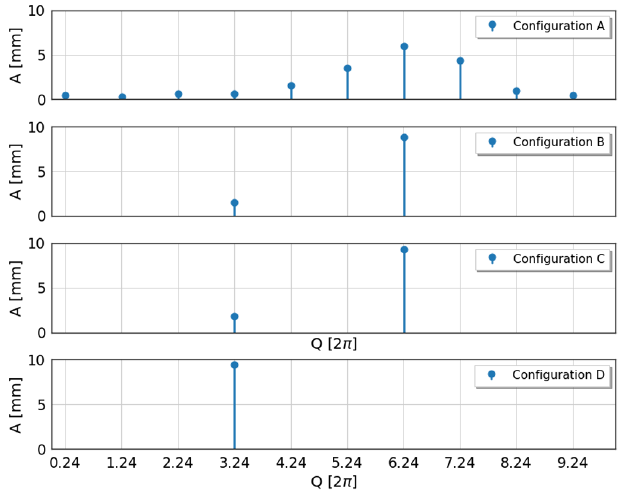
FIG. 11. The Fourier spectra of the mixed BPM signal for the different configurations of BPMs that are used in the analysis. The name of each configuration is shown in the legend.